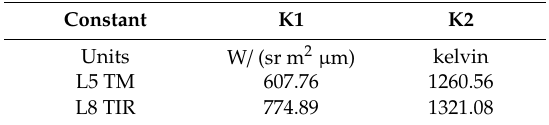
Table 1. Brightness temperature constant values for use with Equation